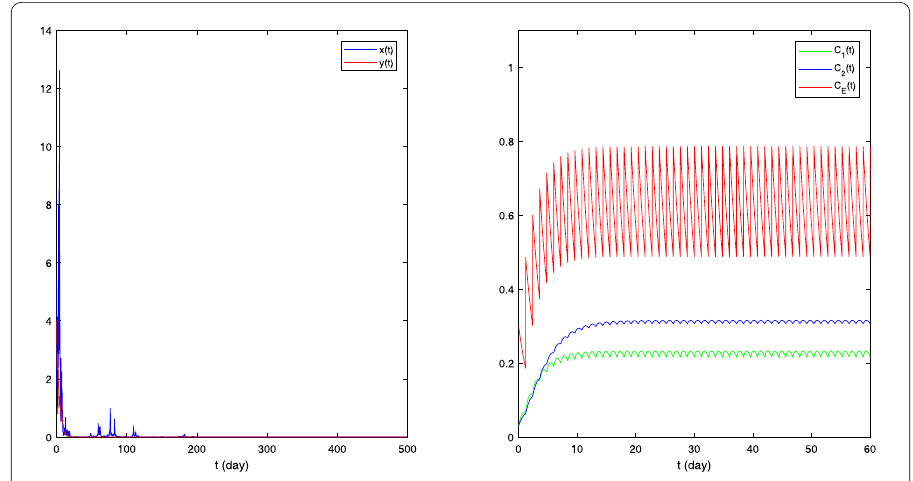
Figure 1 The sample paths of stochastic model (5.1) with π = (0.9,0.1), a 1 = (0.62,0.8), b 1 = (0.021,0.04), α = 0.2, β = 0.1, r 1 = 0.9, σ 1 = 1, a 2 = (0.2,0.4), b 2 = 0.04, k = 0.2, r 2 = 0.8, σ 2 = 0.2, ρ = 1.2, x 0 = 5, y 0 = 4